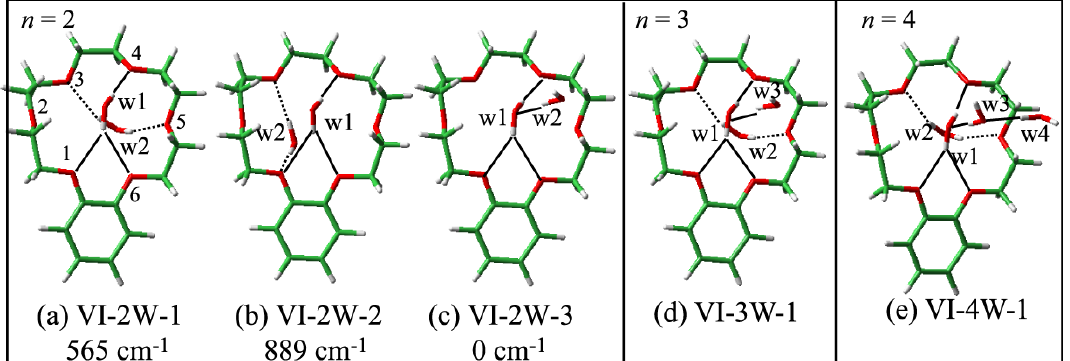
Figure 15. Optimized structures of (a-c) B18C6-(H O) at the B3LYP/6-31+G* level. The numbers shown in cm -1 represent the B18C6-(H 2 4 electronic energies of the isomers relative to that of VI-2W-3. Solid and dotted lines show H-bonding from the front and back sides of B18C6, respectively. Figure adapted from Reference